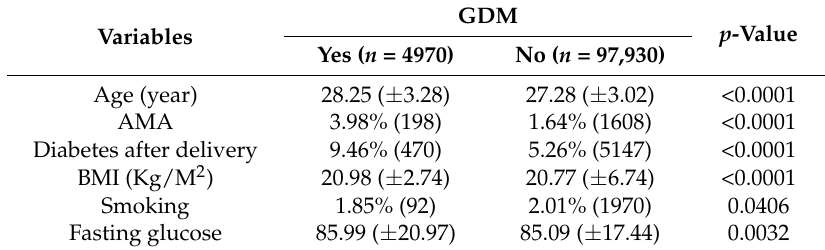
Figure 1. The study population in this study. * NHSE; National Health Screening Examination. Table 1. General Characteristics of study population by gestational diabetes mellitus (GDM).